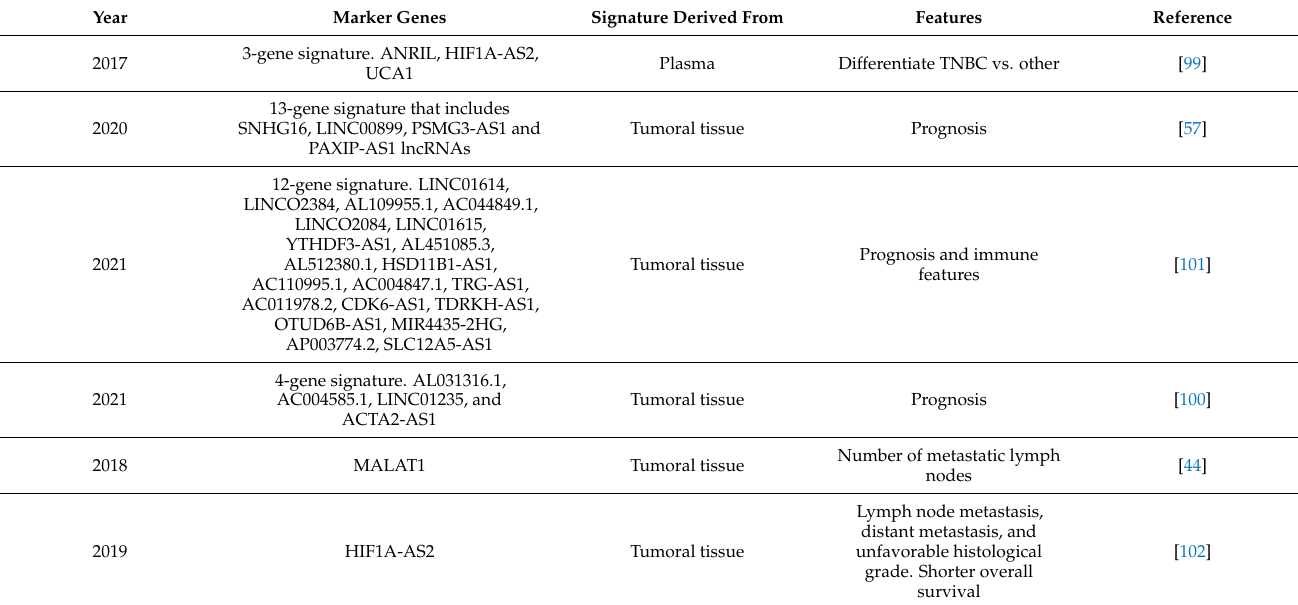
Table 2. Hypoxia-associated molecular lncRNA